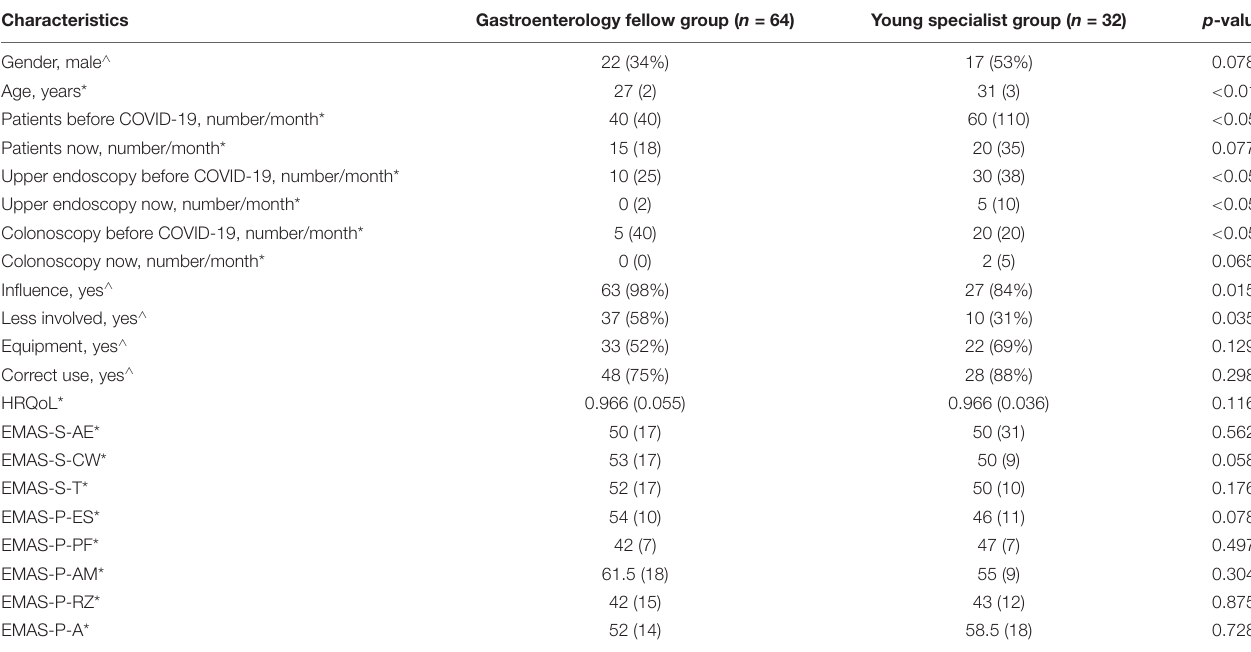
TABLE 2 | Characteristics of physicians for the two groups.